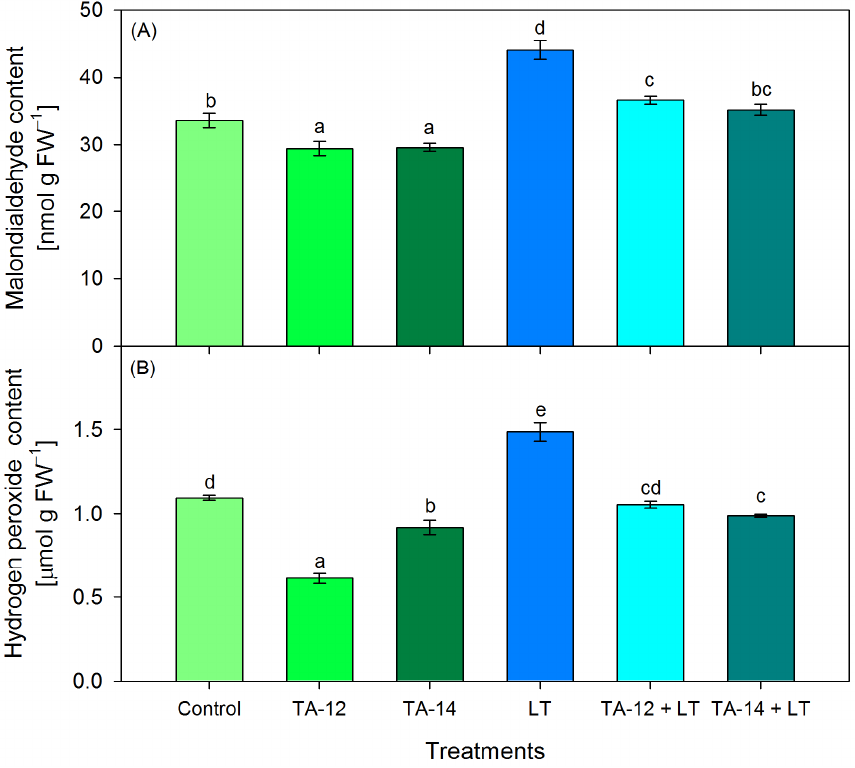
Figure 1. Content of malondialdehyde (MDA) ( A ) and hydrogen peroxide ( B ) in pea sprayed with TA-12 or TA-14 and subjected to low temperature ( − 1 ◦ C, LT) for 24 h. Data are mean values ± SE. Different letters designate statistically significant difference at p <